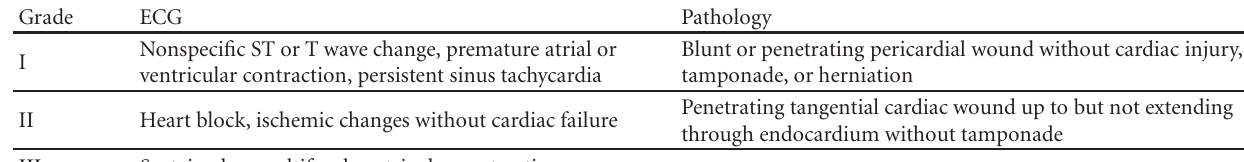
Table 1: Grading of cardiac injury by the American Association for Surgery of Trauma. Adapted from